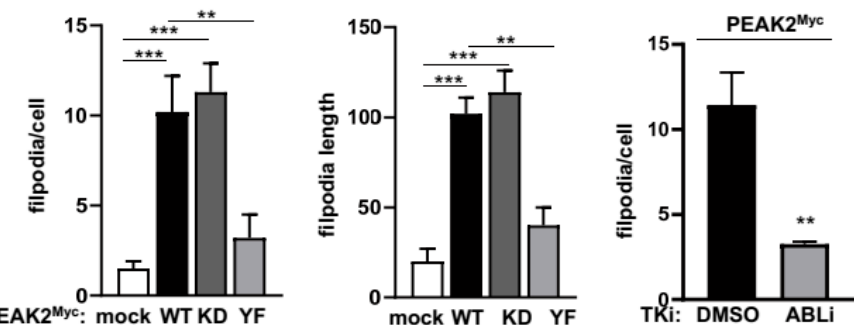
Figure 7. PEAK2 induces ABL-dependent folipodia in CRC cells. ( A ) PEAK2 colocalizes with F-actin structures at focal adhesion of CRC cells. Immunostaining of PEAK2 and F-actin in SW480 cells expressing indicated PEAK2 Myc constructs that were seeded on fibronectin. ( B , C ) PEAK2 induces ABL-dependent filopodia. A representative example ( B ) and quantification ( C ) of filopodia in HCT116 transfected with indicated PEAK2 Myc constructs and treated with DMSO (0.1%) or ABLi (100 nM nilotinib) as indicated for 2 h before cell fixation; mean ± SEM; n = 3; ** p < 0.01; *** p < 0.001 Student’s t -test).